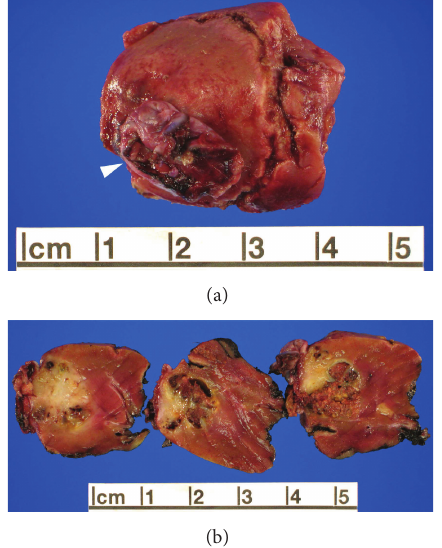
Figure 3: Gross appearance of TLFCK. (a) Partial nephrectomy specimen with ruptured cyst (arrowhead) at the renal capsular surface. (b) Sectioning of specimen reveals a tan-brown partially cystic mass with focal hemorrhage, extending to the ruptured cyst at the capsular